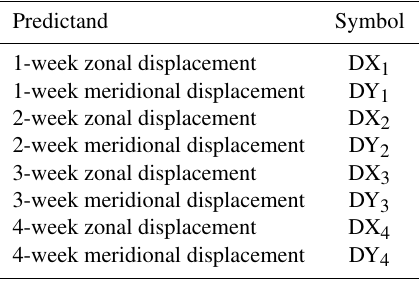
Table 1. The eight predictands used in the predictive